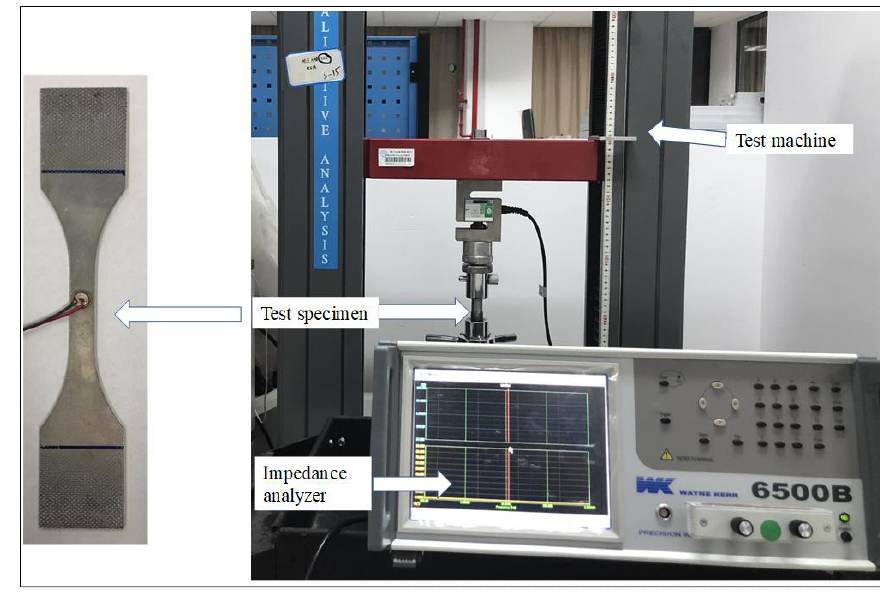
Figure 12. Impedance analysis of the PZT. Table 1. Material of adhesive in the experiment.